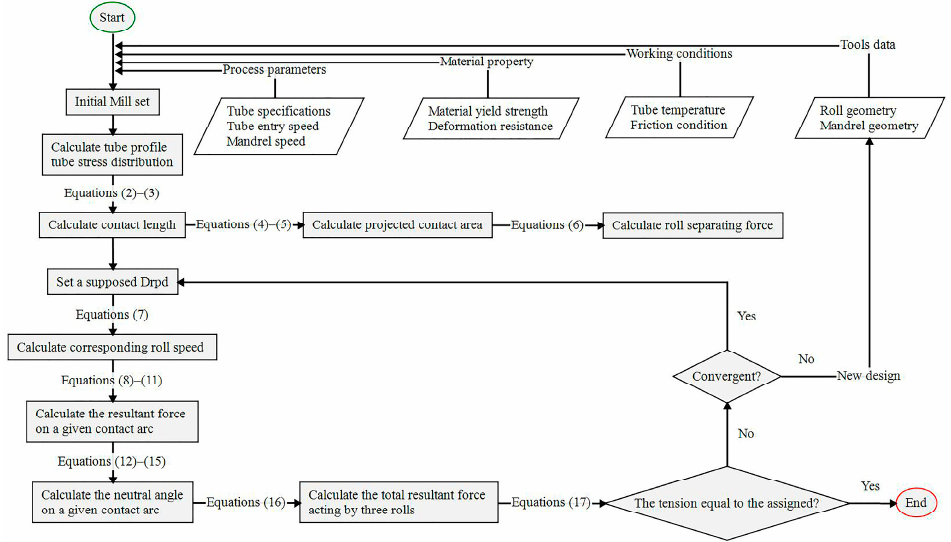
Figure 6. Flowchart of the related calculations in the implementation of the model.